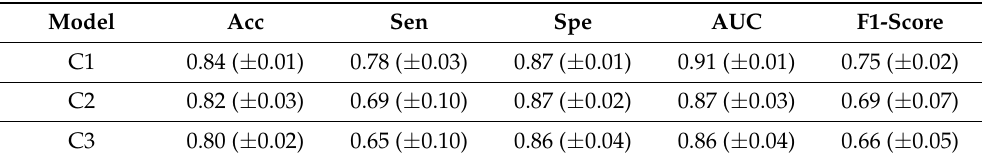
Table 4. Results for the models in K-fold CV for the leave-one-out test set with the respective mean and standard deviation for the 5 folds of each